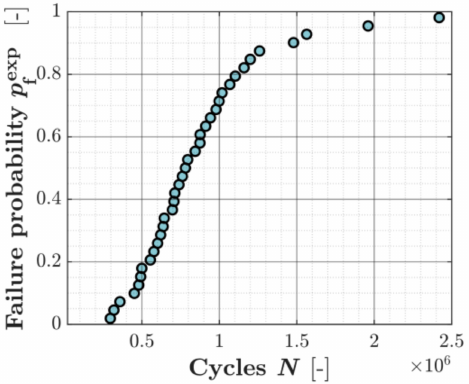
Figure 7. Experimental failure probability using the median rank